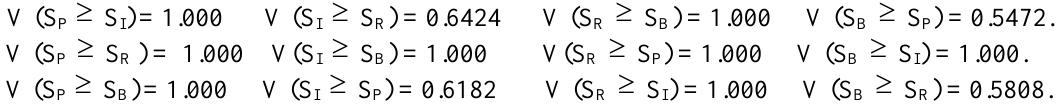
Table 6. The fuzzy comparison matrix for the “profitability”